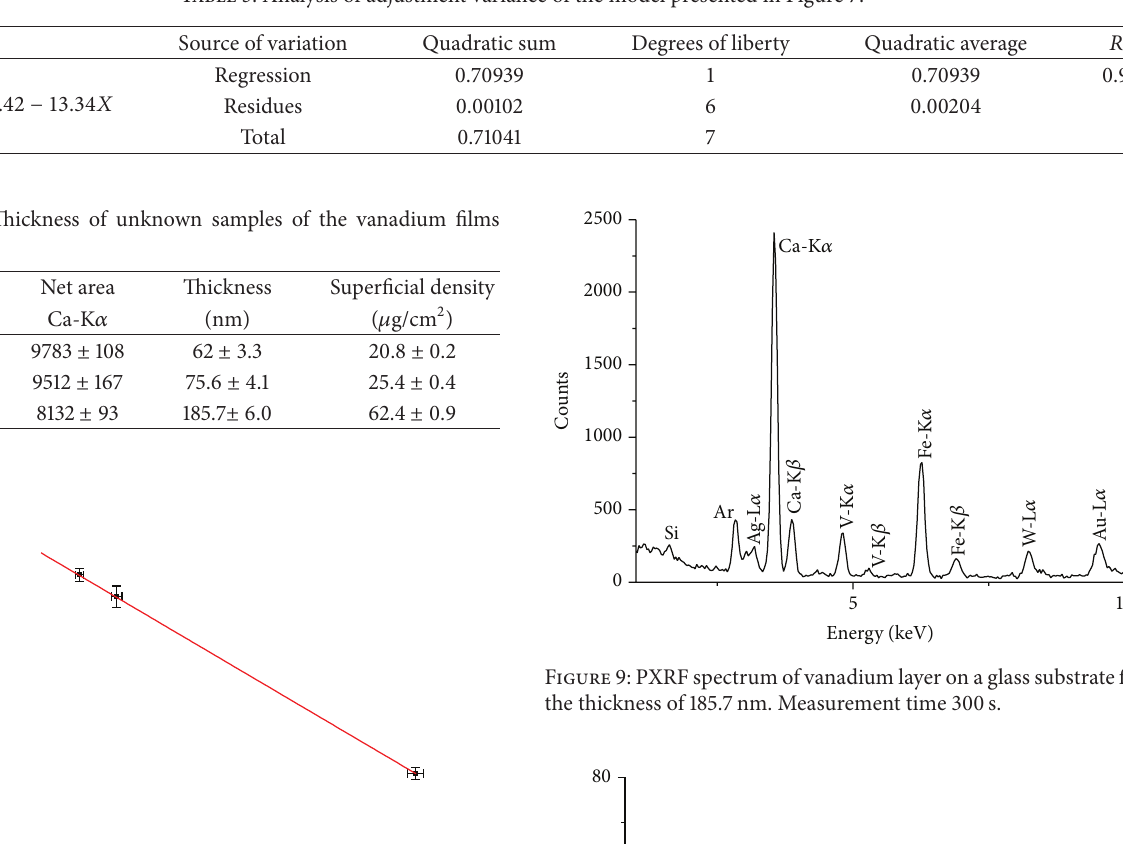
Table 3: Analysis of adjustment variance of the model presented in Figure 7.